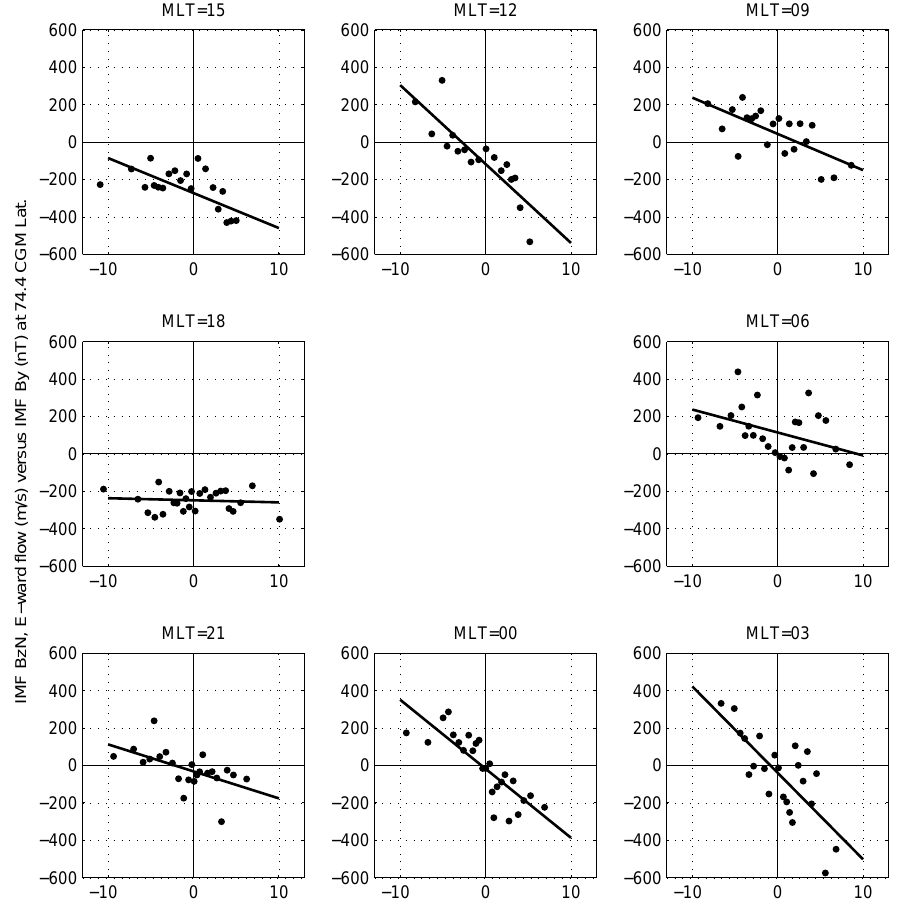
Fig. 3. Same as Fig. 2, but for B z >